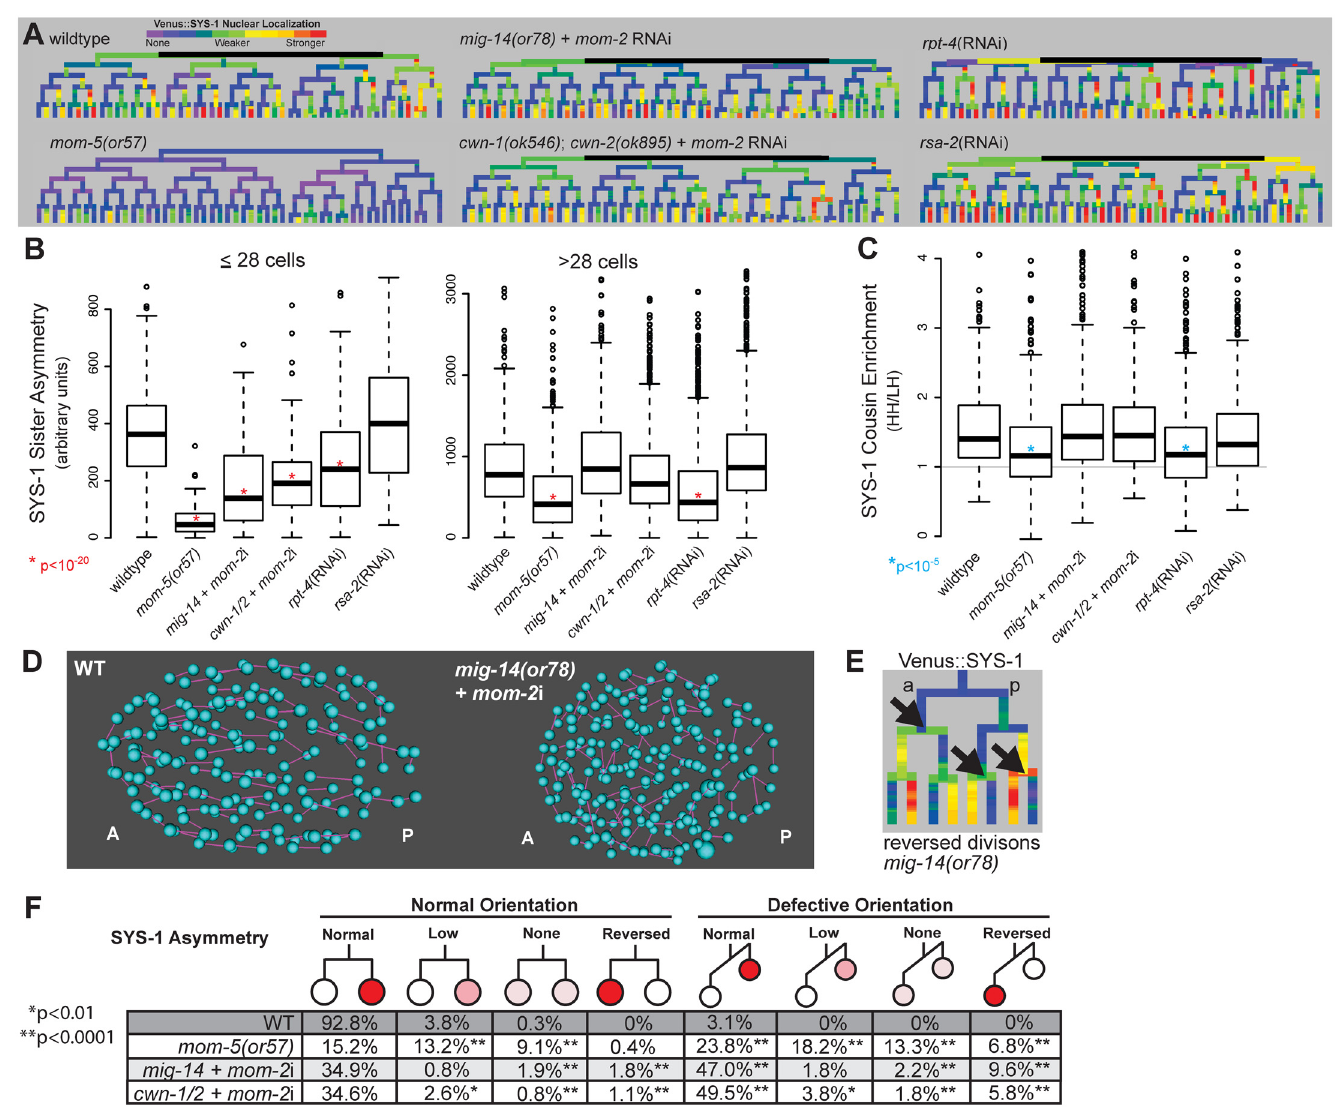
Fig 4. Reduction in Wnt receptor or ligand disrupts nuclear β -catenin asymmetry, cousin enrichment, and division orientations. A) Lineage trees showing examples of Venus::SYS-1 nuclear localization through the 51 cell stage show that in mom-5(or57) frizzled receptor mutants SYS-1 is completely excluded from the nucleus in virtually all early divisions, while mutations that disrupt Wnt ligand, mig-14(or78) and cwn-1(ok546);cwn-2(ok895) that were treated with RNAi against mom-2 , show some divisions with reduced or reversed asymmetry. RNAi against the proteasomal subunit rpt-4 decreases nuclear SYS-1 in some lineages, while RNAi against the centrosome component rsa-2 increases it. B) Boxplots show SYS-1 sister asymmetry is dramatically reduced in early C . elegans Wnt receptor and ligand mutant embryos as compared to wild type (p < 10 − 20 , * ) and reduced only in mom-5(or57) mutant and rpt- 4 RNAi-treated embryos after the 28 cell stage. SYS-1 sister asymmetry is unaffected by rsa-2 RNAi. Edges of the boxes represent the upper and lower quartile, the heavy center line represents the median, the whiskers show the upper and lower bounds, and outliers are shown as circles. C) SYS-1 cousin enrichment (see Fig 3B) is disrupted only in the mom-5(or57) mutant and rpt-4 RNAi-treated embryos. Gray line indicates the SYS-1 cousin enrichment value at which SYS-1 High-High and Low-High cousin nuclear localization are equal (1). D) Division orientations (purple lines) between daughter cells (blue) in wild-type and Wnt ligand mutant embryos at mid-embryogenesis. E) In divisions with reversed polarity (black arrows), the anterior (left) cell has more nuclear SYS-1 than the posterior (right) cell. F) Breakdown of the divisions that have normal or defective orientations and normal, low, none, or reversed SYS-1 asymmetry in wild-type (WT) and Wnt ligand mutant embryos. Total numbers of defective division orientations, cells with reversed polarity and no polarity are significantly different (p < 0.0001, ** ) from wild-type in all three mutant conditions. Divisions with low polarity are also significantly increased for mom-5(or57) and cwn-1/2 + mom-2